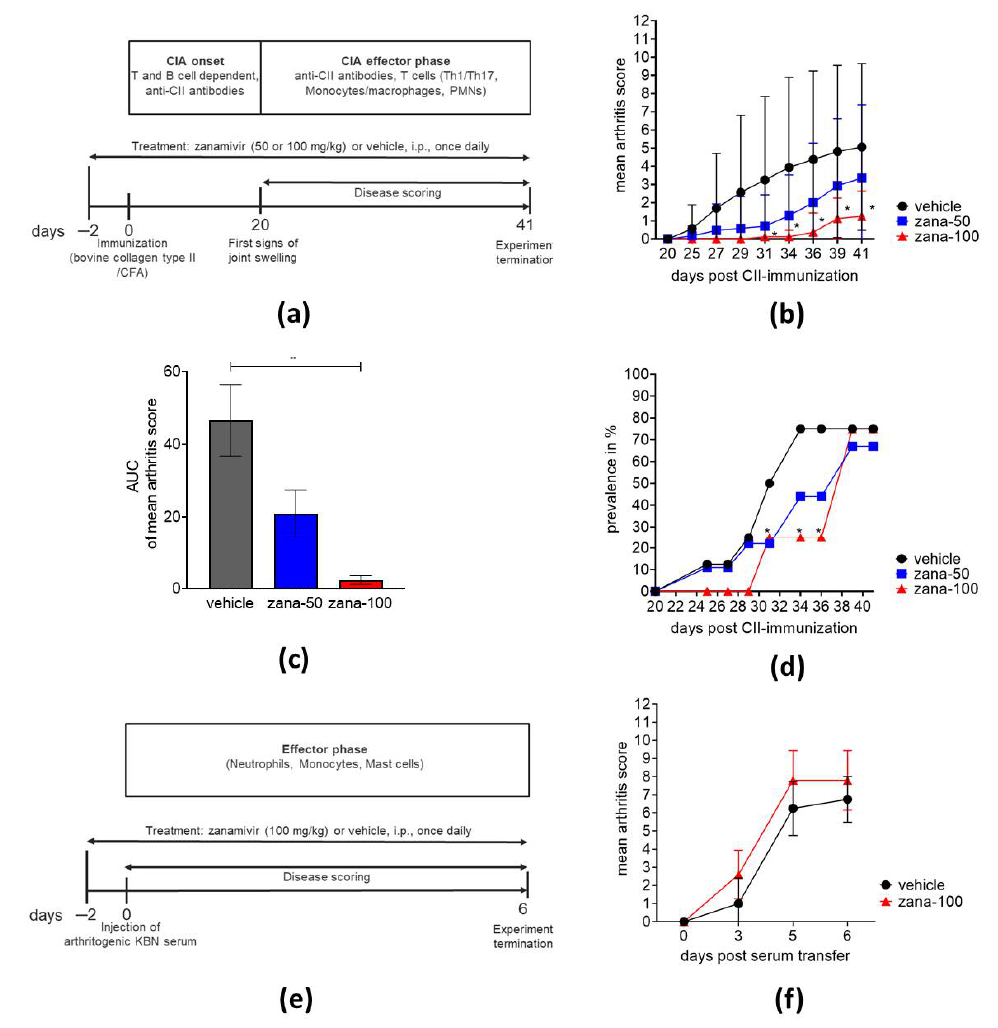
Figure 1. Zanamivir treatment ameliorates collagen-induced arthritis (CIA), but not serum transfer-induced arthritis (STIA). ( a ) Experimental schedule of CIA. Arthritis was induced at day 0 in DBA/1J mice by immunization with a bovine CII/CFA emulsion. Treatment was started two days before immunization. Mice received daily intraperitoneal injections of vehicle, 50 mg/kg zanamivir or 100 mg/kg zanamivir. ( b ) Severity of arthritis is expressed as mean arthritis score. ( c ) Results of “area under curve of mean arthritis score” from day 20 to day 41 are shown. ** p ≤ 0.01. ( d ) Prevalence (number of diseased animals (score >0) at indicated time points) is expressed in percentage (%). ( e ) Experimental schedule of STIA. Arthritis was induced at day 0 in C57BL/6J mice by KBN serum transfer. Treatment was started two days before serum transfer. Mice received daily systemic injections of vehicle or 100 mg/kg zanamivir. ( f ) Mean arthritis score of vehicle and mice treated with 100 mg/kg of zanamir in serum-transfer-induced arthritis (STIA). CIA: vehicle, n =16; zanamivir 50 mg/kg, n = 17; zanamivir 100 mg/kg, n = 8. STIA: vehicle, n = 4; zanamivir 100 mg/kg, n = 5. Results are shown as ± standard deviation (±SD). * p ≤ 0.05. For statistical analysis, we used two-way ANOVA for repeated measures with Tukey’s multiple comparisons test (b), Kruskal Wallis with Dunn’s post hoc test in (c), Fisher’s exact test (d), and unpaired Mann–Whitney U test in (f).